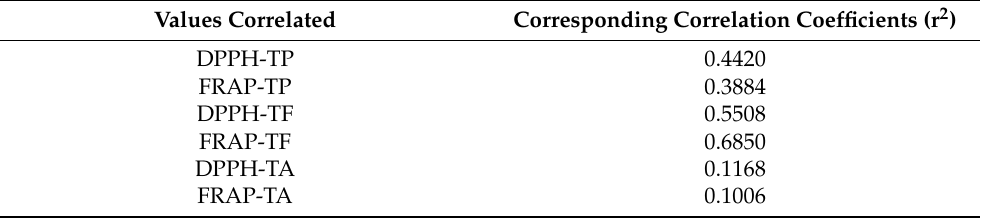
Table 4. Statistical parameters as calculated from correlations established using regression analysis at a 99.9% ( p = 0.001) [23].